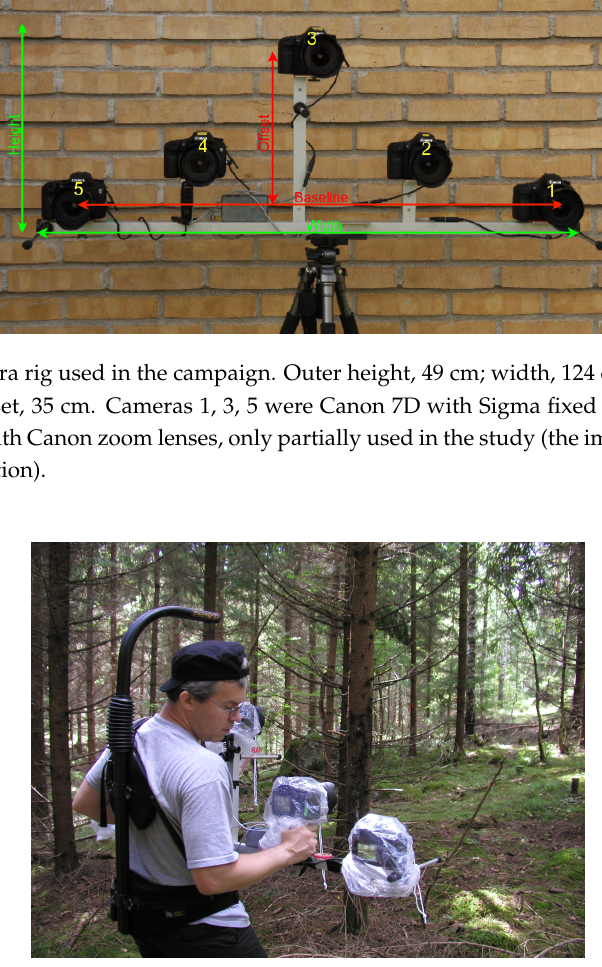
Figure 2. The five-camera rig in the field with rain covers, carried with EasyRig